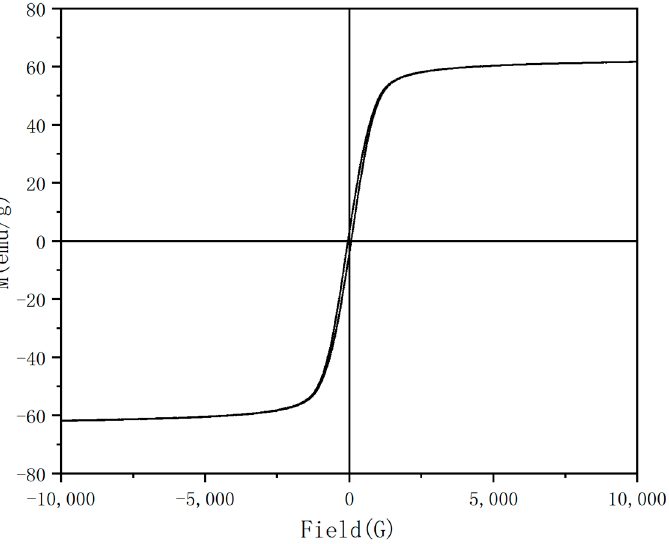
Figure 11. Hysteresis loop diagram of Fe 3 O 4 nanoparticles by microwave reaction for 4 h.